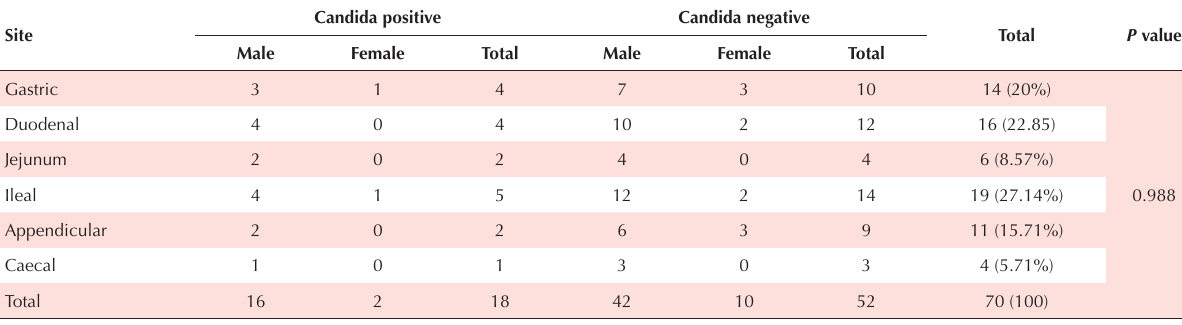
Table 1. Site of perforation in relation to fungal positivity